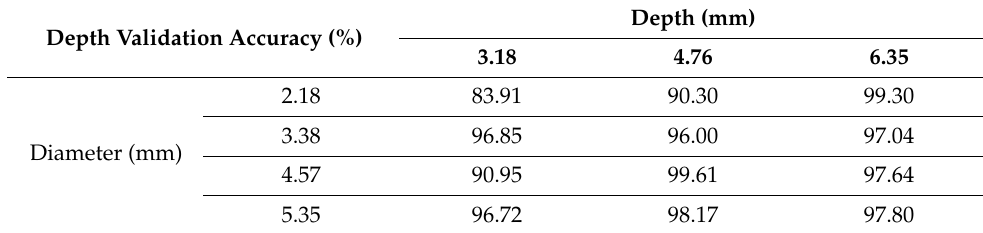
Table 16. Detailed validation accuracy of MISO ANN model for depth